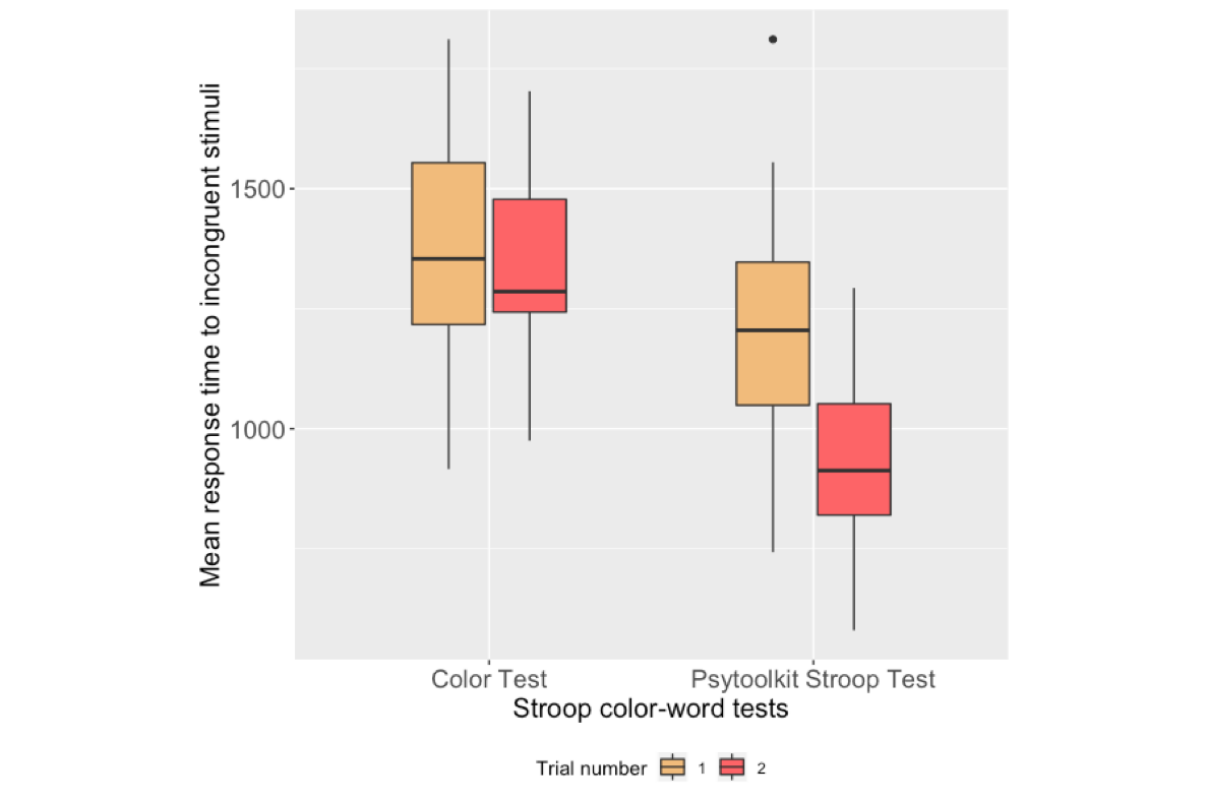
Figure 11. Box plots of participants’mean response times to incongruent stimuli during the Stroop